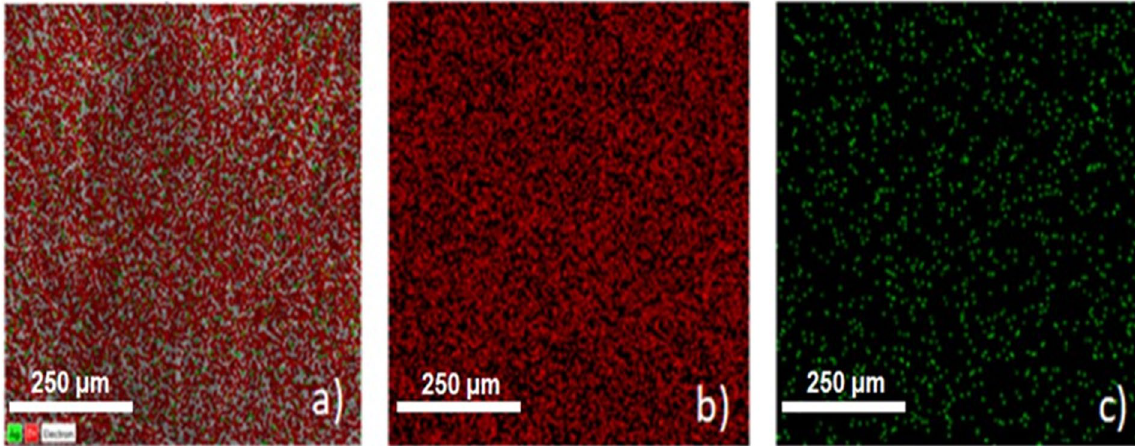
Figure 3. Overlaid EDS images for sample containing CA-ZnO-Ag ( a ) with corresponding identification of components: zinc in red ( b ) and silver in green ( c ).